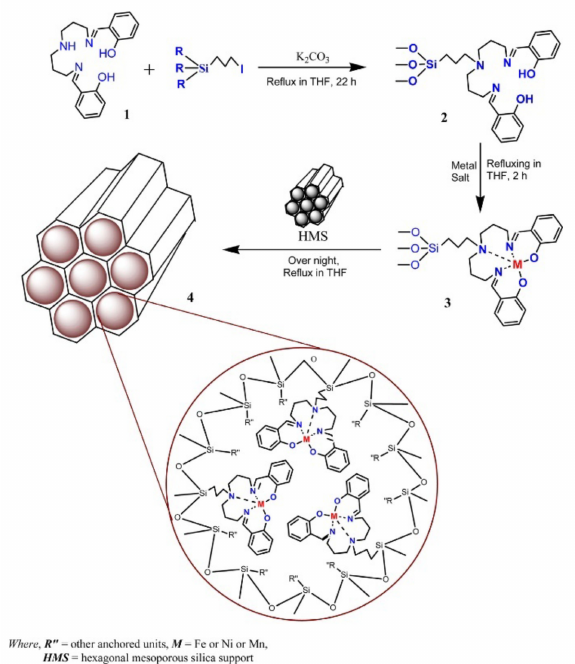
Figure 14. Scheme of the experimental procedure to immobilize Fe, Ni, or Mn complexes on HMS–hexagonal mesoporous silica though covalent bonding. Reproduced with permission from Reference [136] Copyright (2013) Elsevier